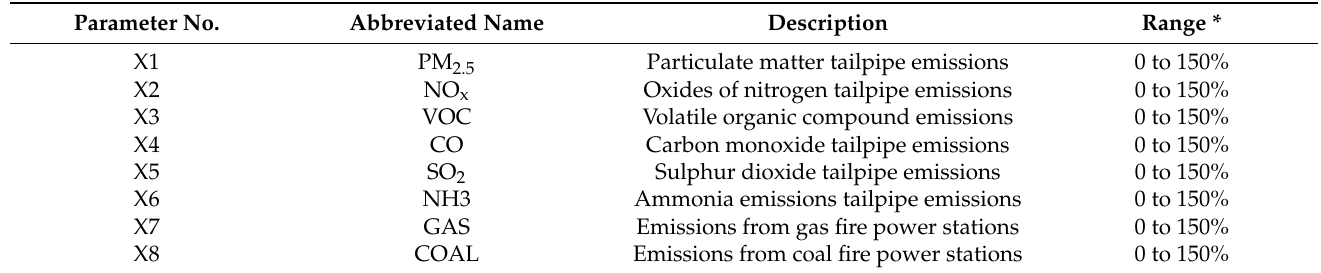
Table 1. Model parameters and their distribution ranges for this